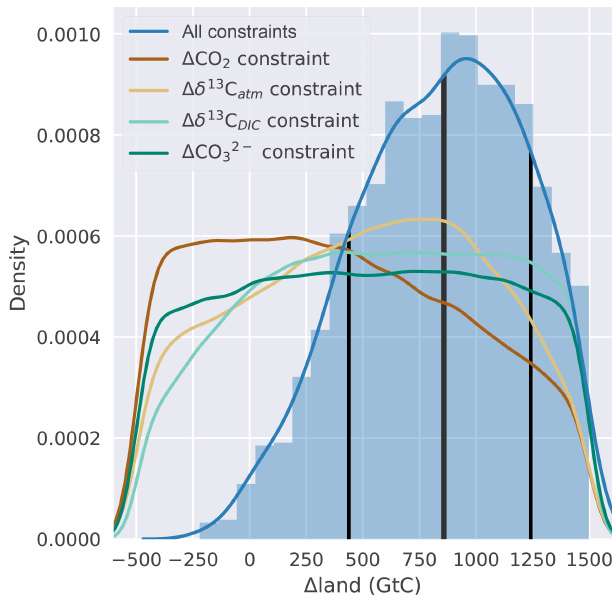
Figure 5. Histogram (blue bars, normalized) and kernel density es- timate (blue line) of (cid:49) land wherein parameter combinations fulfill all four data-based constraints. The thick vertical black line indi- cates the median (cid:49) land of ∼ 850GtC, and thin black lines show the ± 1 σ range. The remaining four lines show kernel density es- timates of (cid:49) land when considering one data-based constraint at a